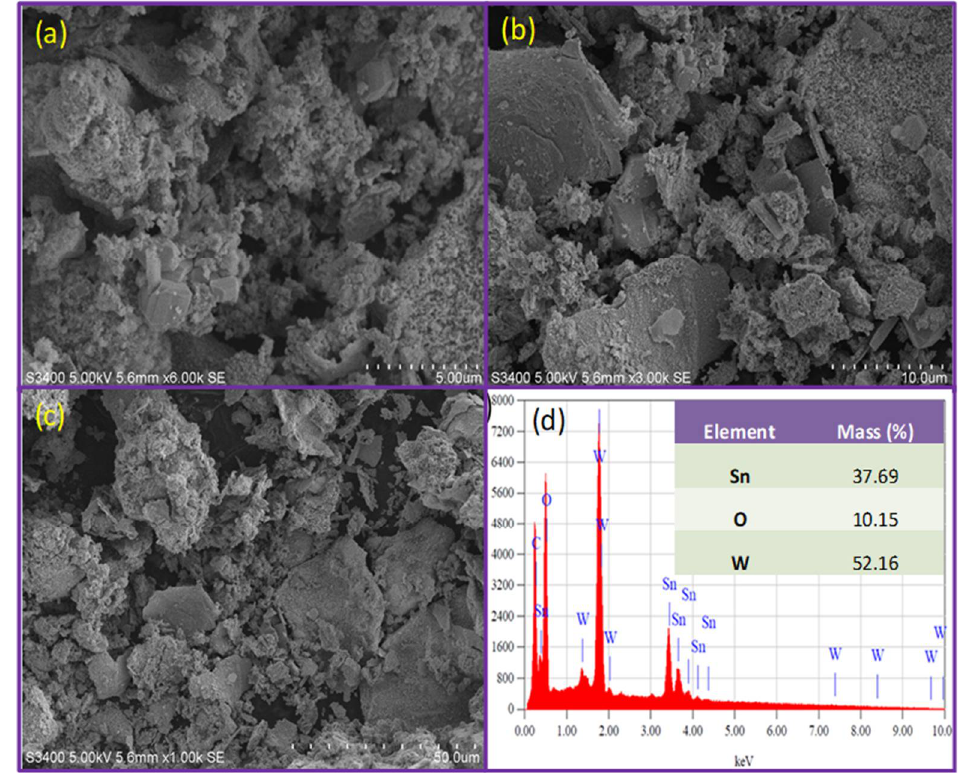
Figure 5. ( a – c )SEMimagesand( d )EDXspectrum(inset: elementalcomposition)of β -SnWO 4 Figure 5. ( a – c ) SEM images and ( d ) EDX spectrum (inset: elemental composition) of β-SnWO 4 na- noparticles.